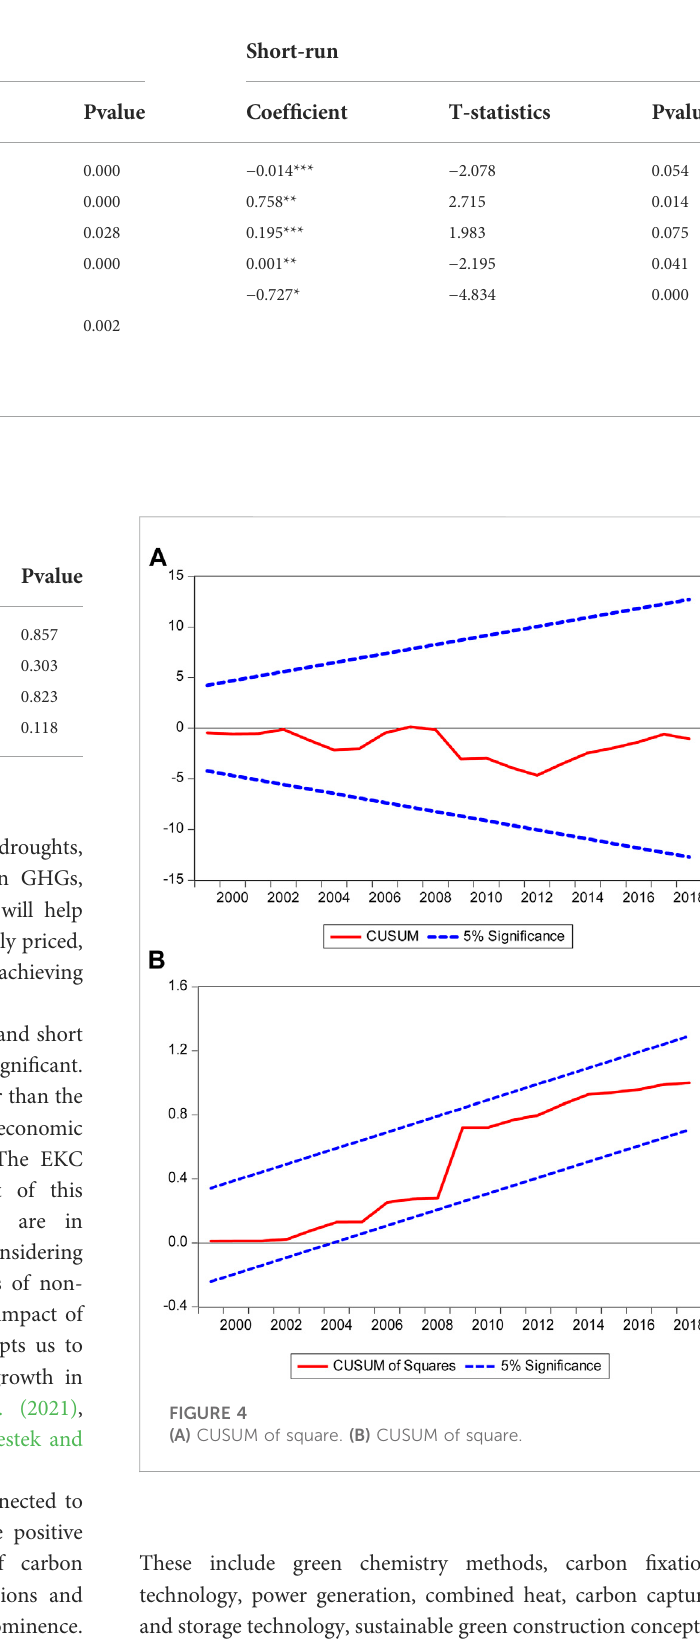
TABLE 6 Dynamic ARDL results.